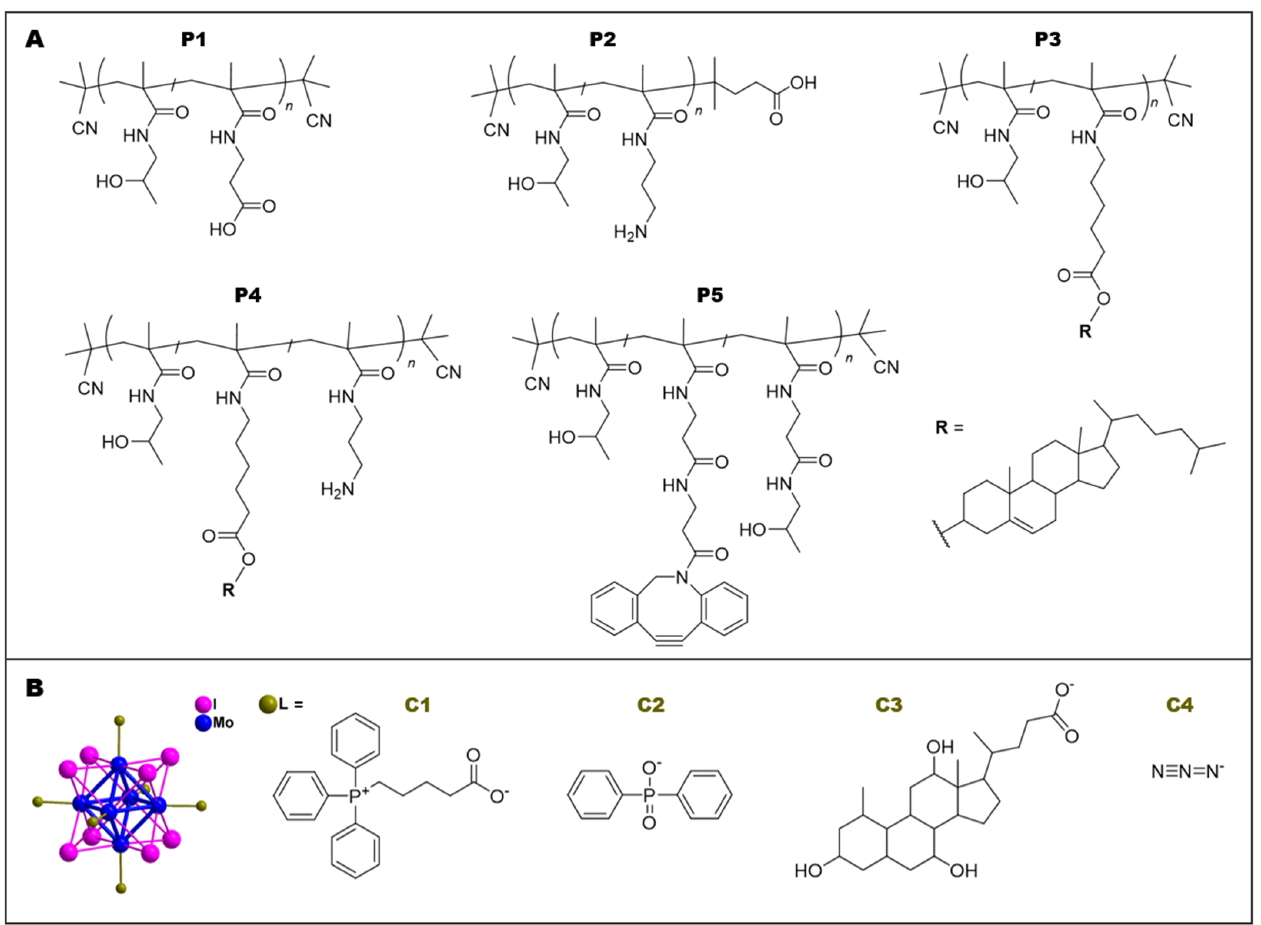
Table 1. Detailed synthetic procedures and the ratio between monomers, chain transfer agents, and initiators are described in Supplementary Materials. 1 H NMR spectra of pol ‐ ymer precursors P3 and P4 are shown in Supplementary Materials.